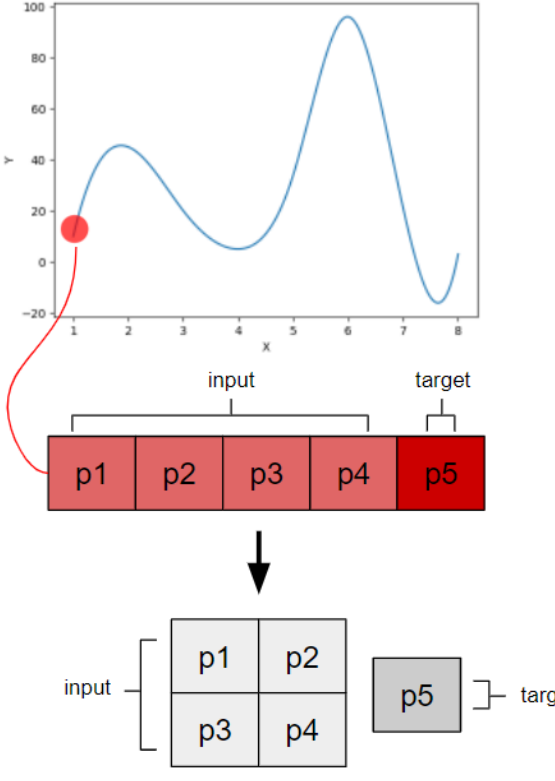
Figure 1. Data structure for Conv-LSTM